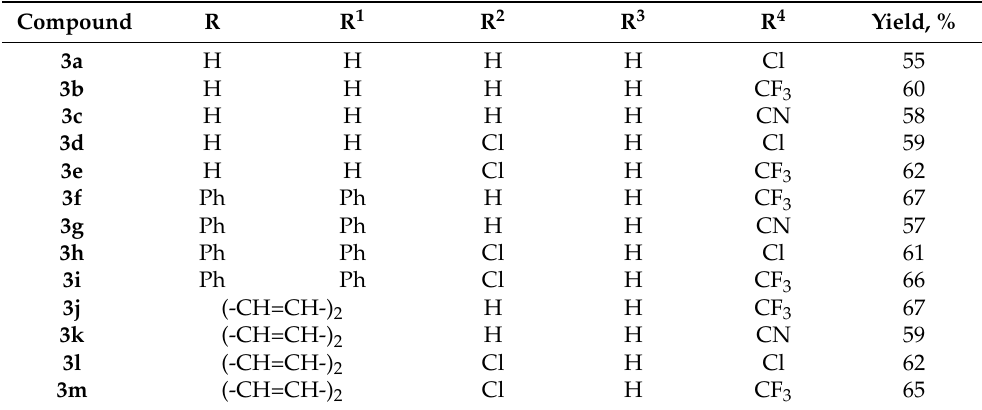
Table 1. Structure characterization and yeilds of synthesized compounds 3a – m .